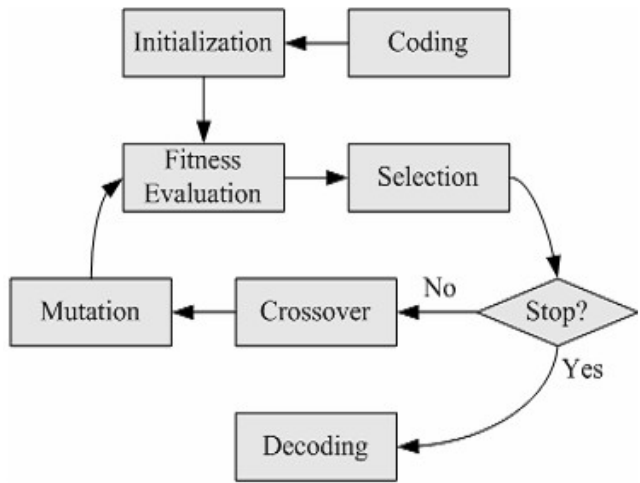
Figure 5. Scheme of the standard